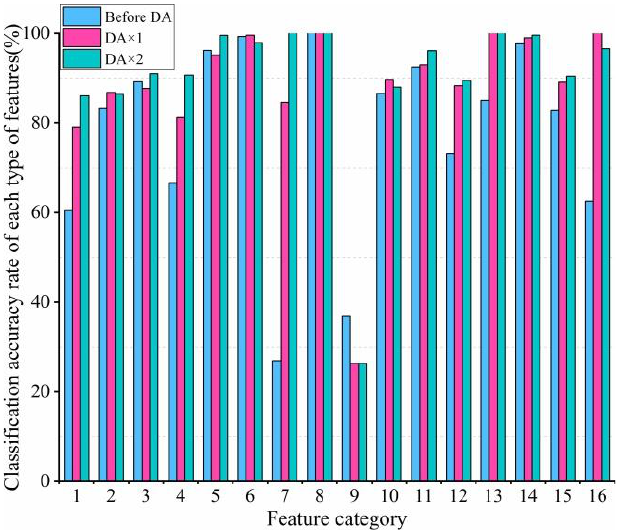
Figure 5. Classification accuracy of each type of feature, before and after DA operation, with 520 samples.